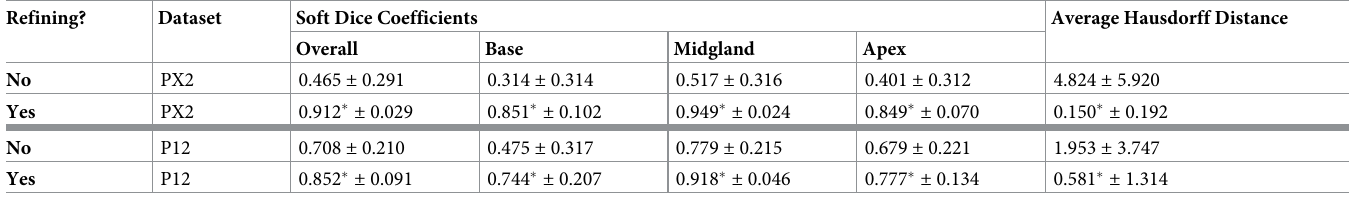
Table 2. Evaluation results for retargeted